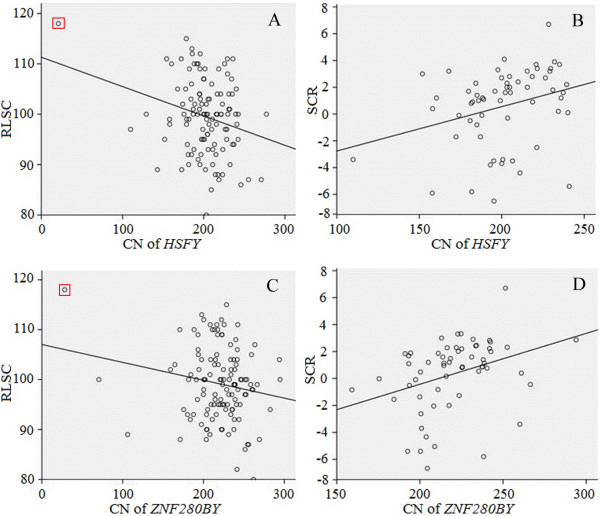
Correlations between the CNV of HSFY and ZNF280BY and male reproductive traits in Holsteins. The CNV of HSFY was (A) negatively associated with RLSC (r = -0.249, P = 0.008) and (B) positively associated with SCR (r = 294, P = 0.021). The ZNF280BY CNV was (C) negatively associated with RLSC (r = -0.174, P = 0.055) and (D) positively associated with SCR (r = 0.339, P = 0.008). Each circle represents one individual. The animal that has the lowest CN of HSFY and ZNF280BY was marked with a red square.